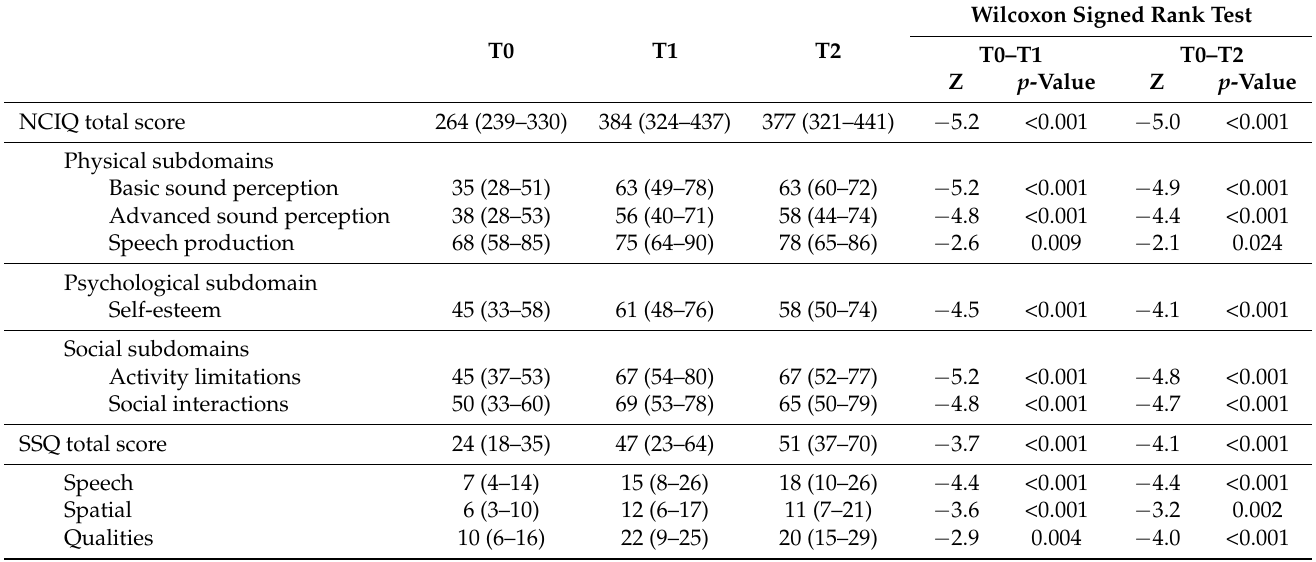
Table 5. Summary of patient-reported outcome measures showing significant improvements between the evaluation time points T0 (baseline), T1, and T2 (post-implantation) using a Wilcoxon signed rank test. Z-statistics and p values are